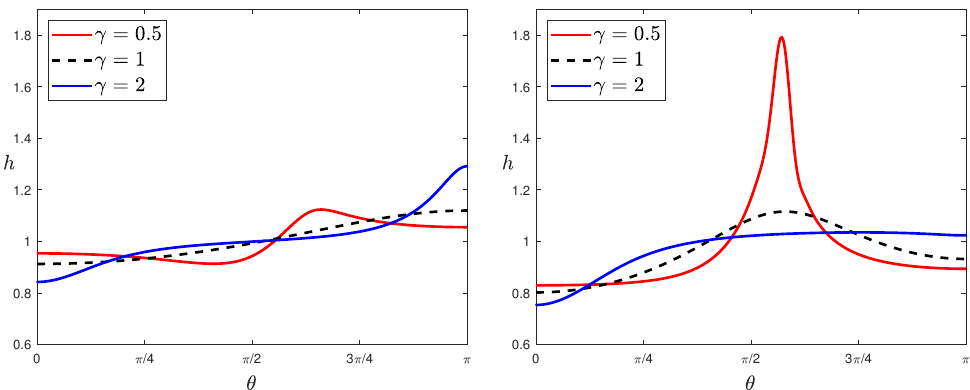
Figure 5. Variations in the steady thickness profiles for Bo = 0.0057; the geometric parameter is γ = 0.5, 1, 2. ( left ) Without rotation, Ω d = 0; ( right ) With rotation, Ω d =